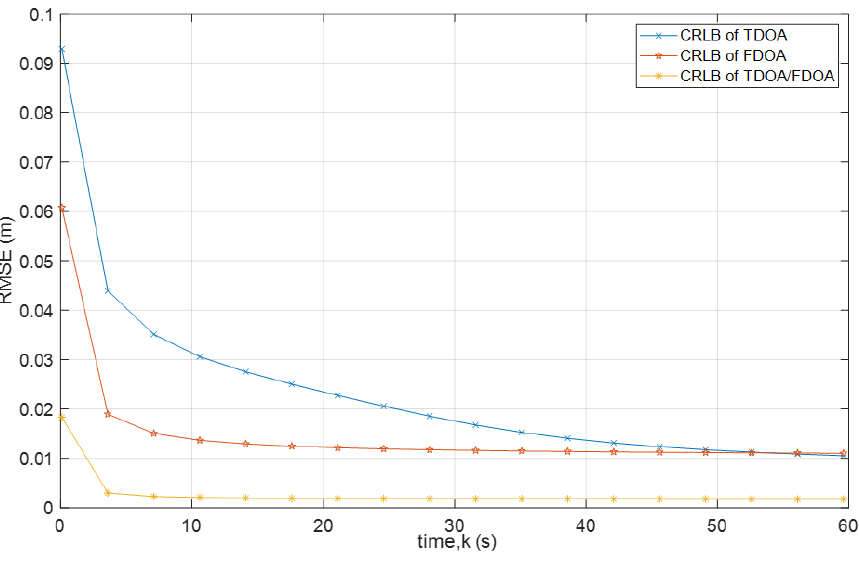
Figure 11. RMSE for TDOA, FDOA, and